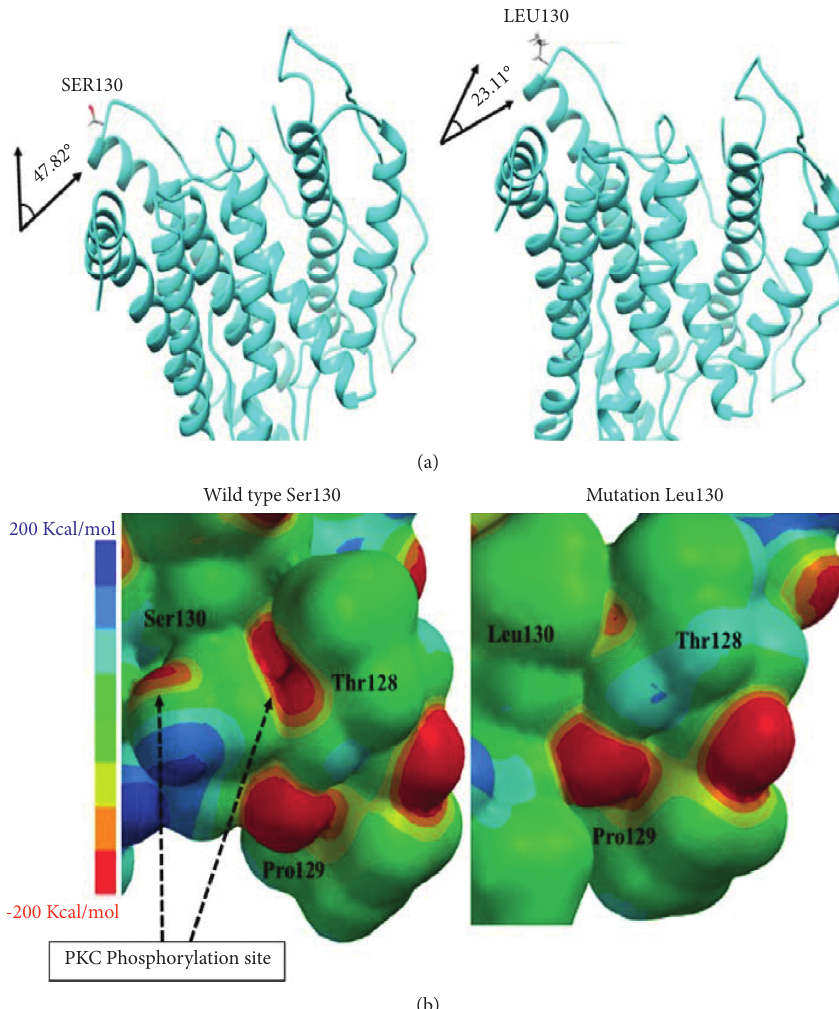
Figure 6: Structural and electronic changes of Ser130Leu mutation. (a) Topological changes of angle. (b) Electrostatic potential map in range of 200kJ/mol to −